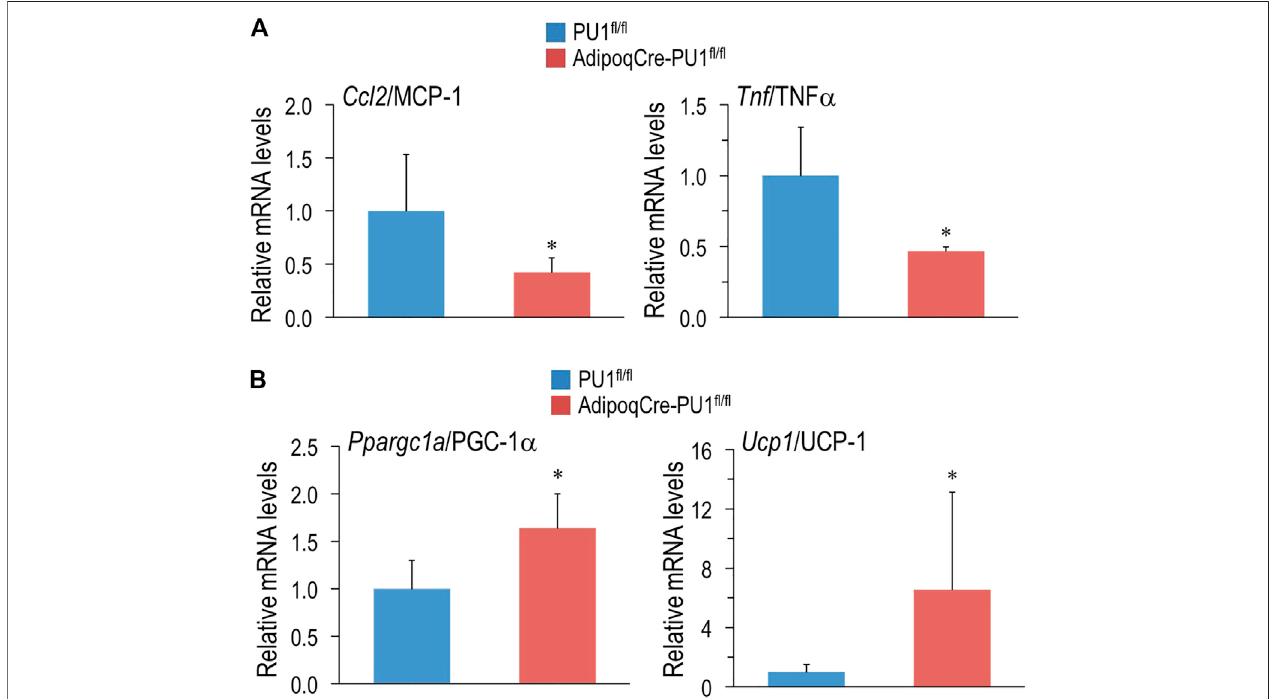
FIGURE7| LossofPU.1 inAdipocytes ReducesIn fl ammatoryGeneExpressionandPromotes ThermogenicGeneExpression. (A) Adipocyteswereisolatedfrom the gonadal adipose tissue and mRNA expression of ccl2 /MCP-1 and TNF α were measured using real-time RT-PCR. (B) Brown adipose tissue mRNA expression of PGC-1 α and UCP1 and TNF α were measured using real-time RT-PCR. N (cid:1) 5 vs. 5, * p <